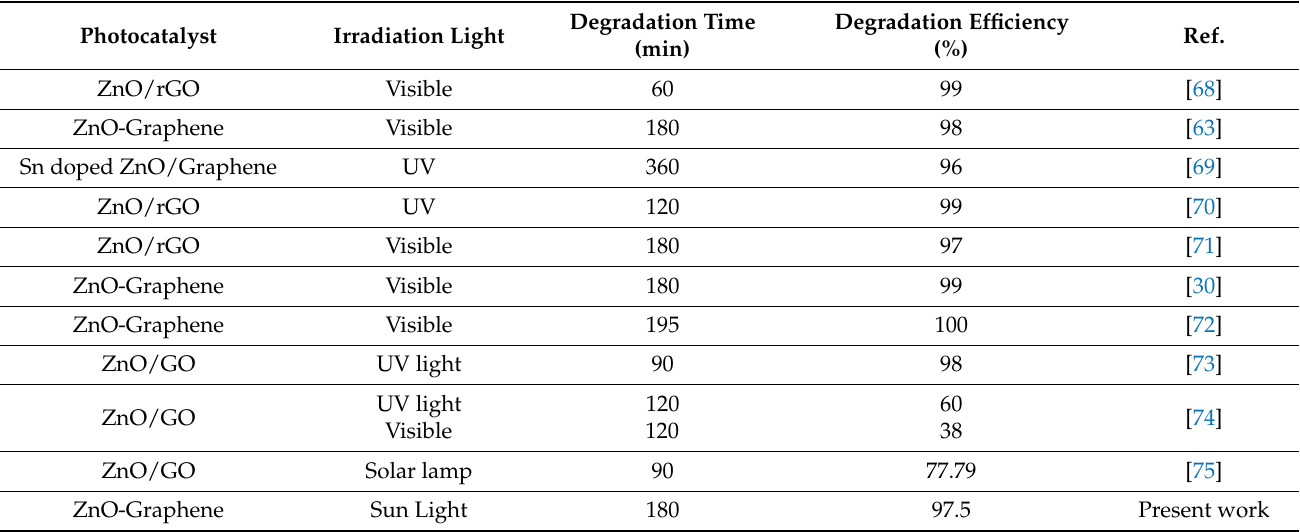
Table 2. Comparison of photocatalytic degradation efficiency of ZnO/graphene (S2) with available reports of ZnO/graphene nanocomposites prepared by other methods.